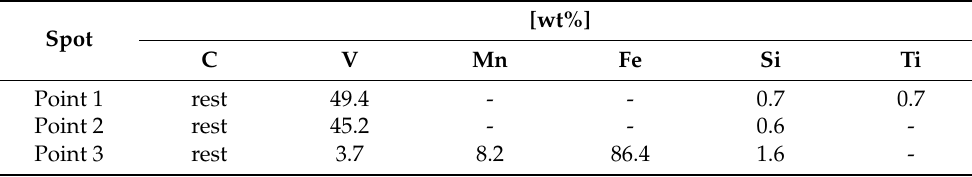
Figure 8. ( a ) examples of secondary carbides visible in an alloy containing 6.3% V. ( b ) red marks denote places of analysis for the alloy containing 8.1% V.